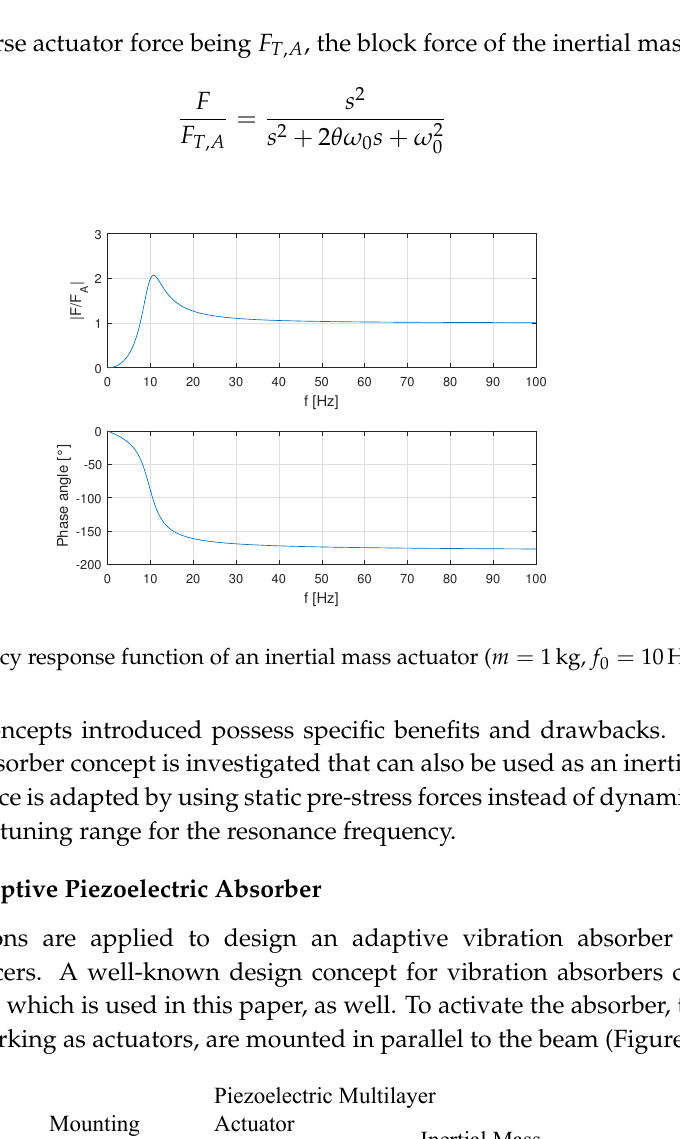
Figure 3. Principle of an inertial mass actuator.